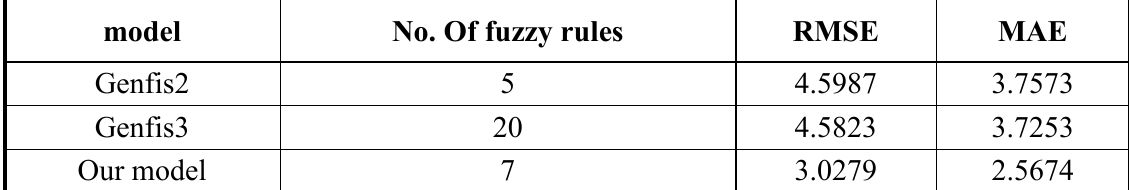
Table 2. The comparison of different